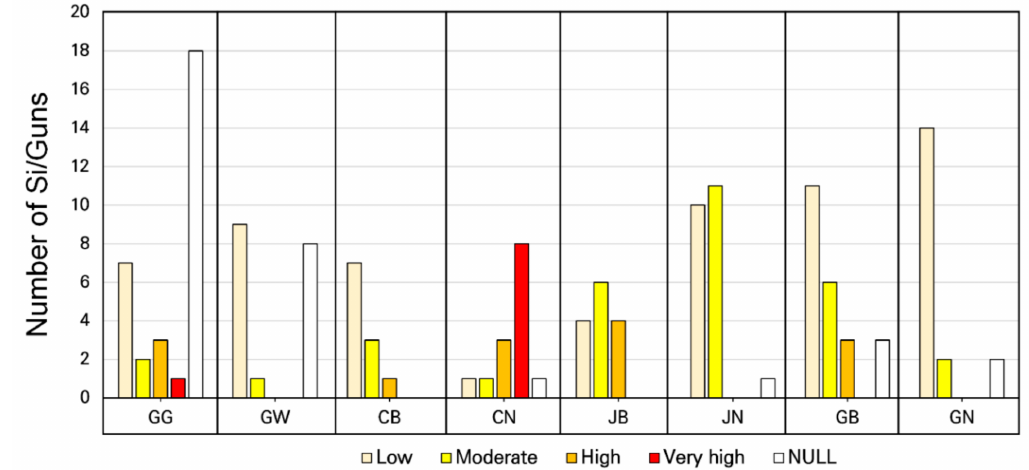
Figure 6. Number of each small administrative boundary of the eight provinces-level across South Korea as determined by the agricultural drought vulnerability